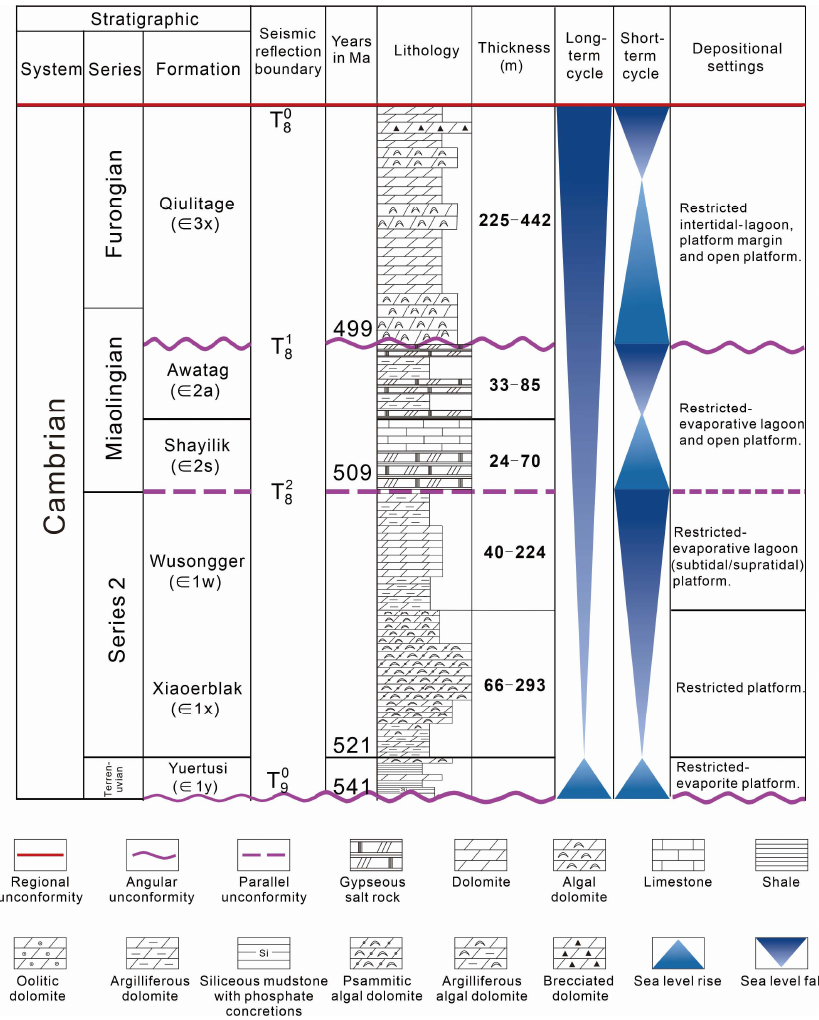
Figure 2. Evolution of Cambrian strata, unconformity, sedimentary environment, and main periods in the central and western Tarim Basin [37,38].